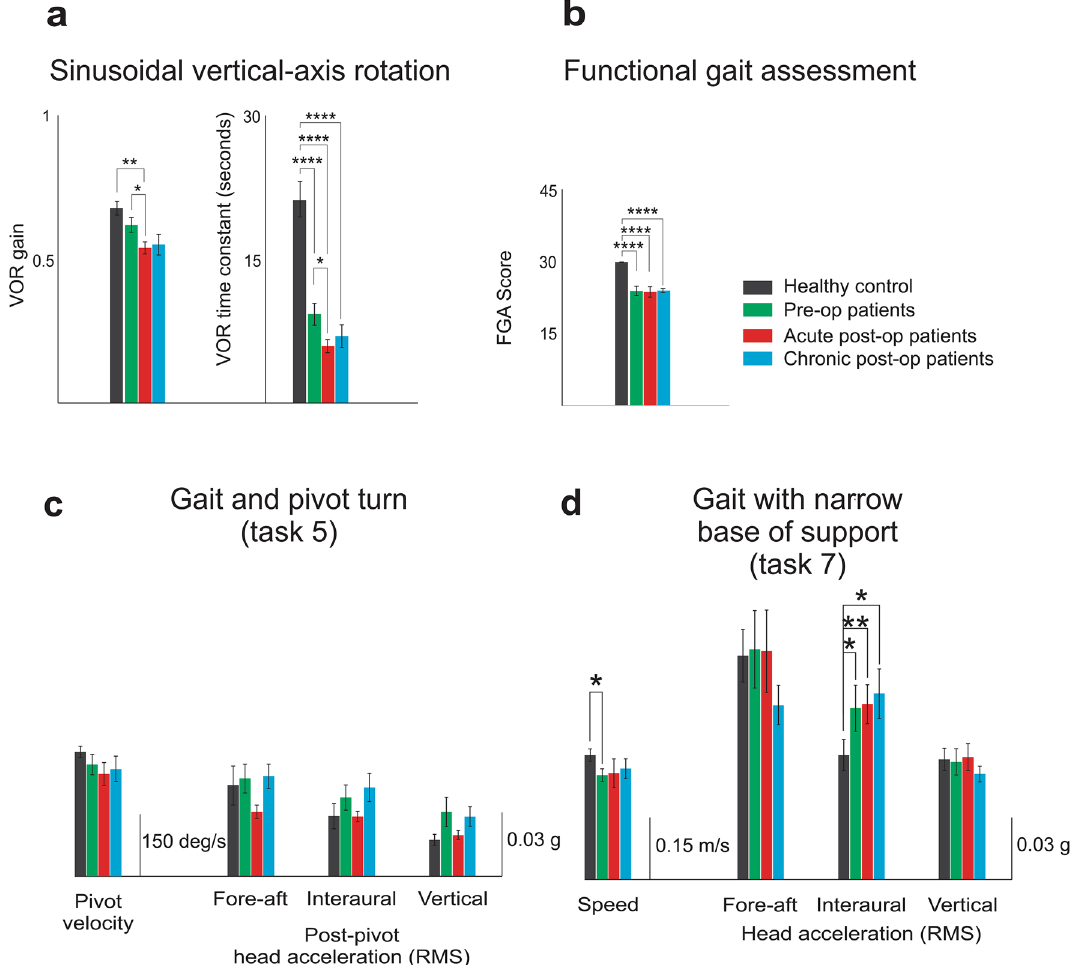
Figure 2. ( a ) Vestibular function of patients assessed via VOR gain (left panel) and time constant (right panel). ( b ) Functional capacity of patients assessed by FGA scores. ( c ) Objective kinematic measures during ‘gait and pivot turn’ (task 5): pivot velocity and root mean square of post-pivot head acceleration for all three axes. ( d ) Objective kinematic measures during ‘gait with the narrow base of support’ (task 7): completion speed and root mean square of head acceleration for all three